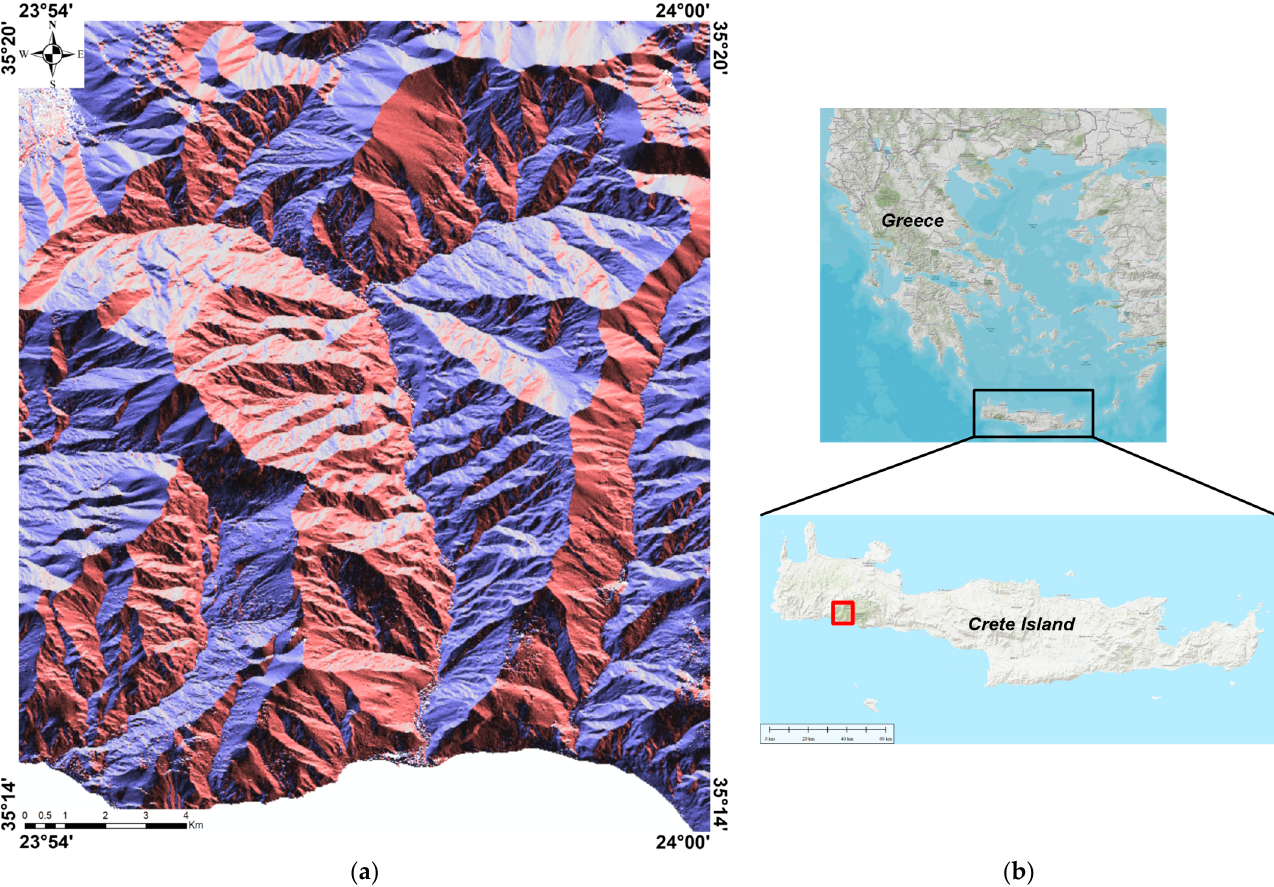
Figure 2. ( a ) Digital Elevation Model (DEM) of Samaria Gorge; ( b ) Location of Samaria Gorge in